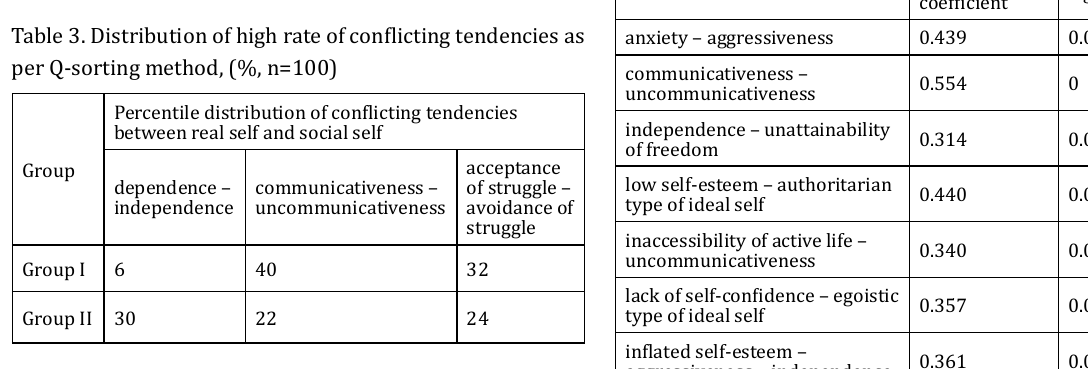
Table 4. Significant correlations in blogger